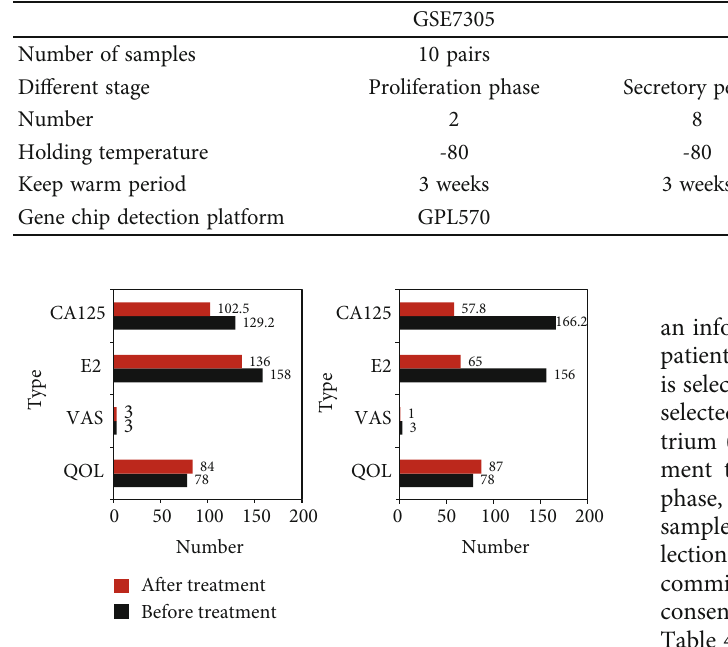
Figure 10: Two groups of patients undergoing related index test before B-ultrasound